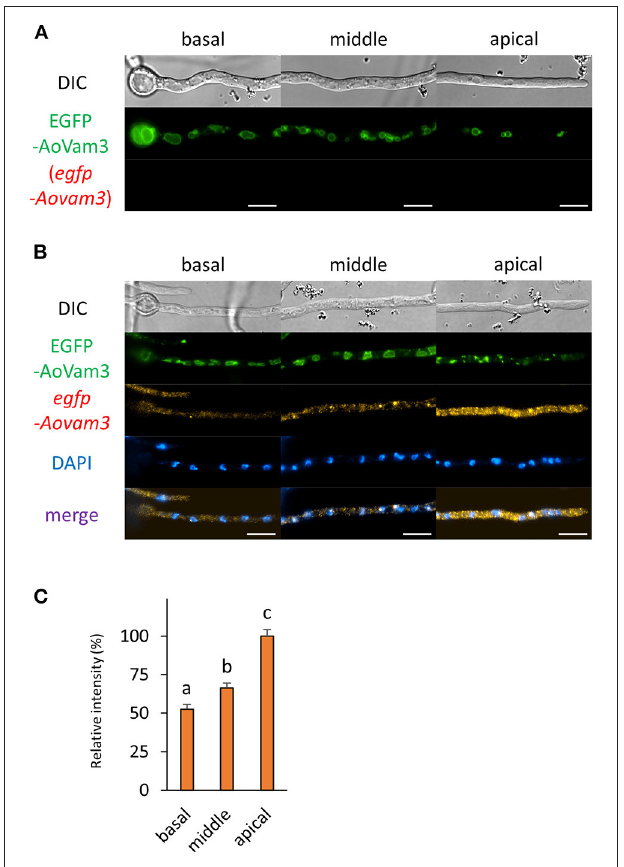
FIGURE 8 | The fluorescence derived from AoUapC-EGFP protein and AouapC-egfp mRNA was observed in hyphal cells of the AoUapC-EGFP-expressing strain. (A) AoUapC-EGFP was observed in live cells. (B) smFISH with egfp probe resulted in the observation of the fluorescence of AoUapC-EGFP and AouapC-egfp mRNAs. Nuclei were stained with DAPI. Bars, 10 µ m. (C) Relative fluorescence intensity of AouapC-egfp mRNA was determined at apical, middle, and basal cells. Bars show mean with standard error. Significant difference at P < 0.05 among each lowercase (Tukey–Kramer test, n = 10